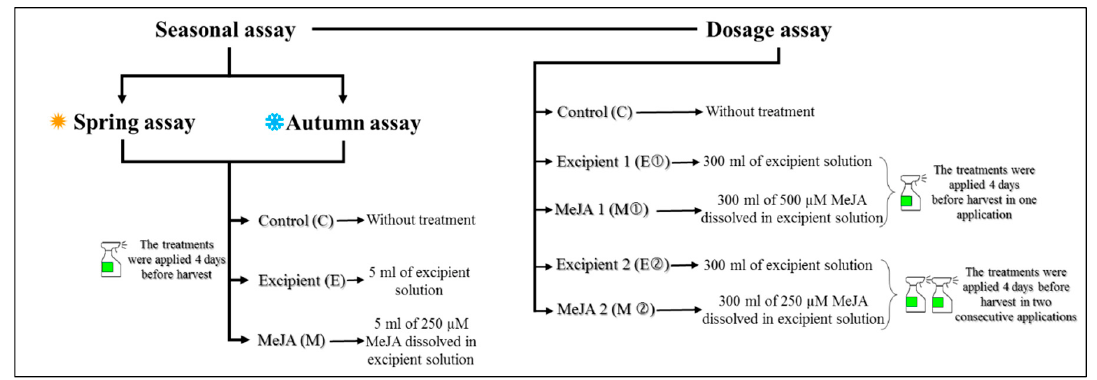
Figure 1. Experimental design of three assays.